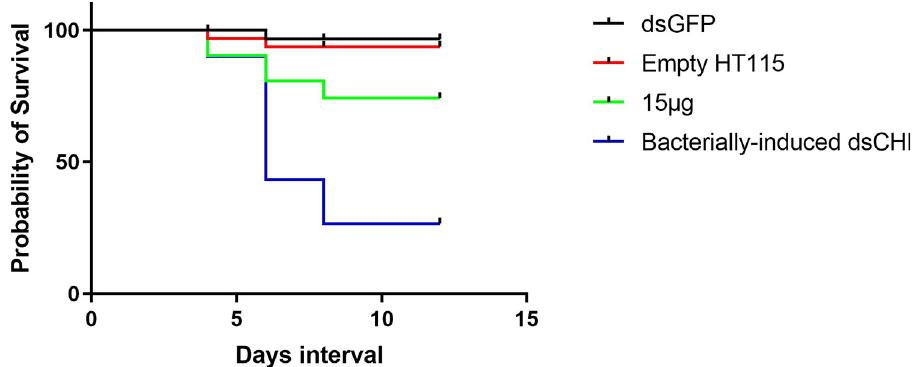
Fig 3. Kaplan-Meier analysis indicating survival after feeding purified dsCHI and bacterially-induced dsCHI to C . partellus